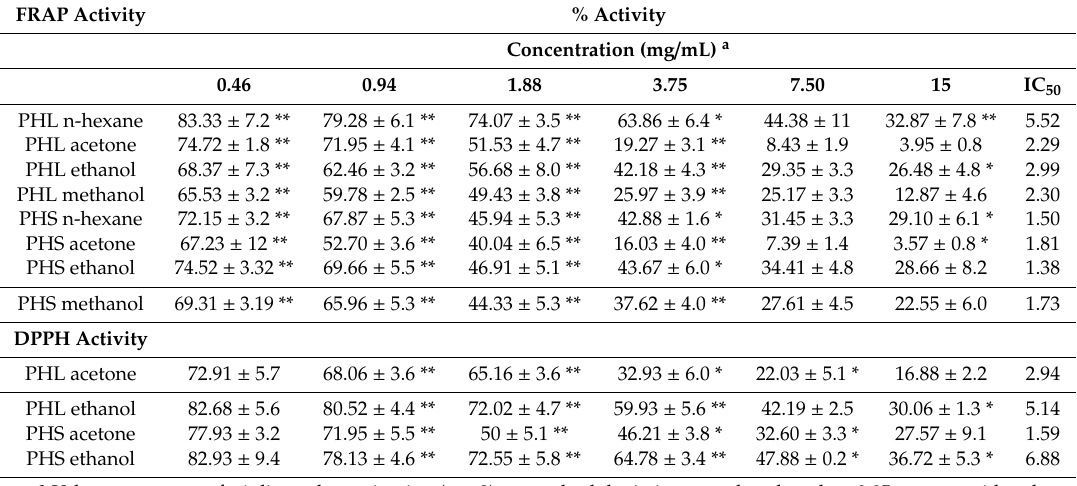
Table 2. Antioxidant activity of P . hydropiper extracts in different solvents at different concentrations.